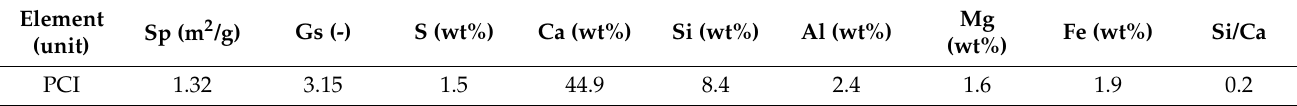
Table 3. Main physical and chemical characteristics of the binders